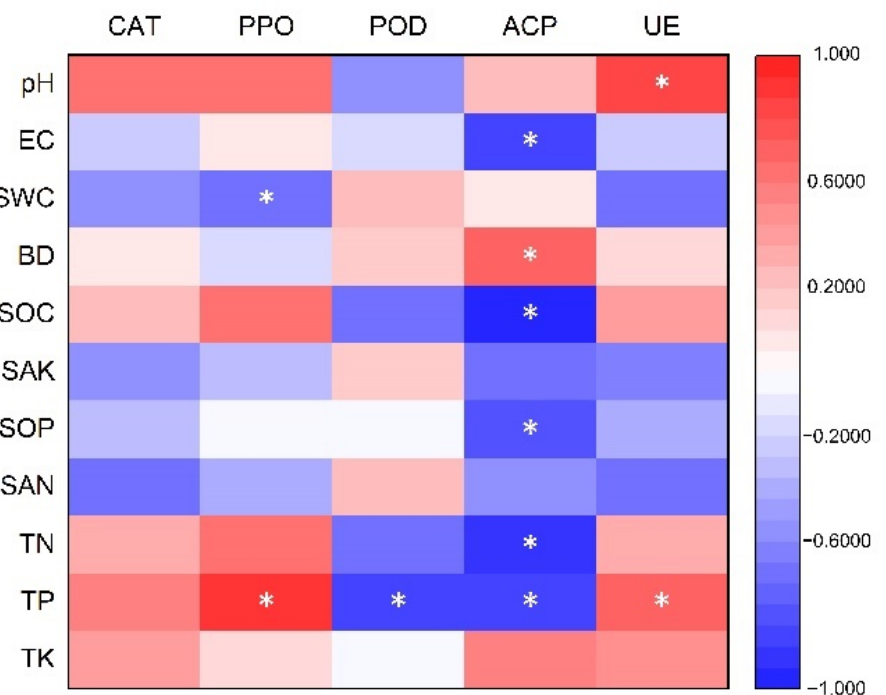
water content (SWC), soil bulk density (BD), soil organic carbon (SOC), soil-available relation, and the darker the color, the stronger the correlation. Electrical conductivity (EC), soil wa-